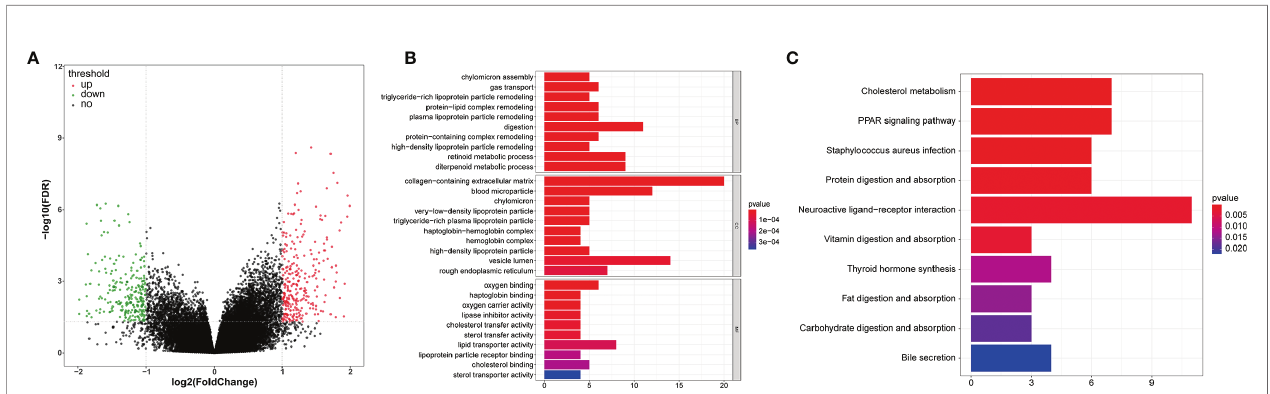
FIGURE 9 | GO and KEGG enrichment analyses of the DEGs between high- and low-risk groups in RCRC patients. (A) A volcano plot of DEGs in the high- and low-risk groups. Red indicates up-regulated genes, green indicates down-regulated genes (high-risk group versus low-risk group), and black indicates no signi fi cant difference. The Top 10 biological processes, cellular components, molecular functions (B) and KEGG pathways (C) were illustrated. The color of the bar demonstrates P-value. Therefore, blue bars have a more signi fi cant P-value than red